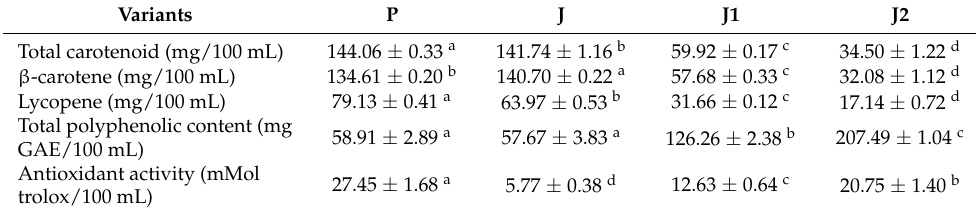
Table 6. Phytochemical profile and antioxidant activity by DPPH assay of Rosehip juices.